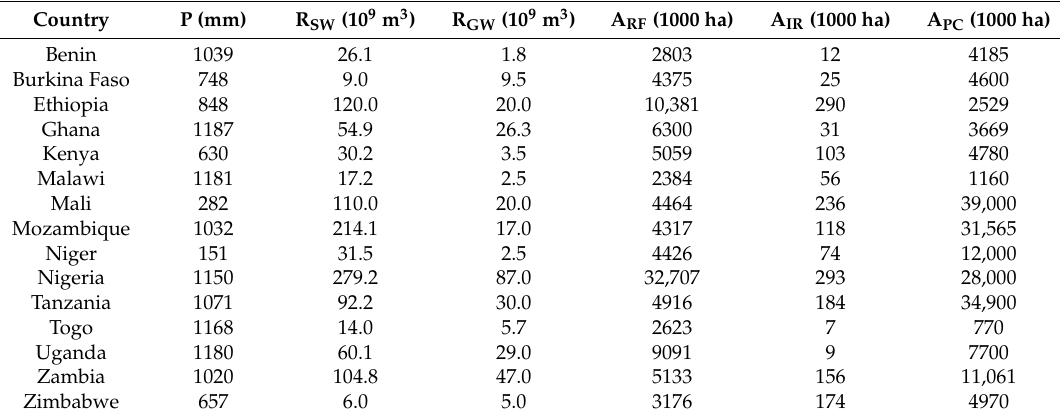
Table 1. Annual renewable water resources and current cultivated and potential cultivable area (FAO) [26], in the 15 selected countries in Sub-Saharan Africa (SSA). Country